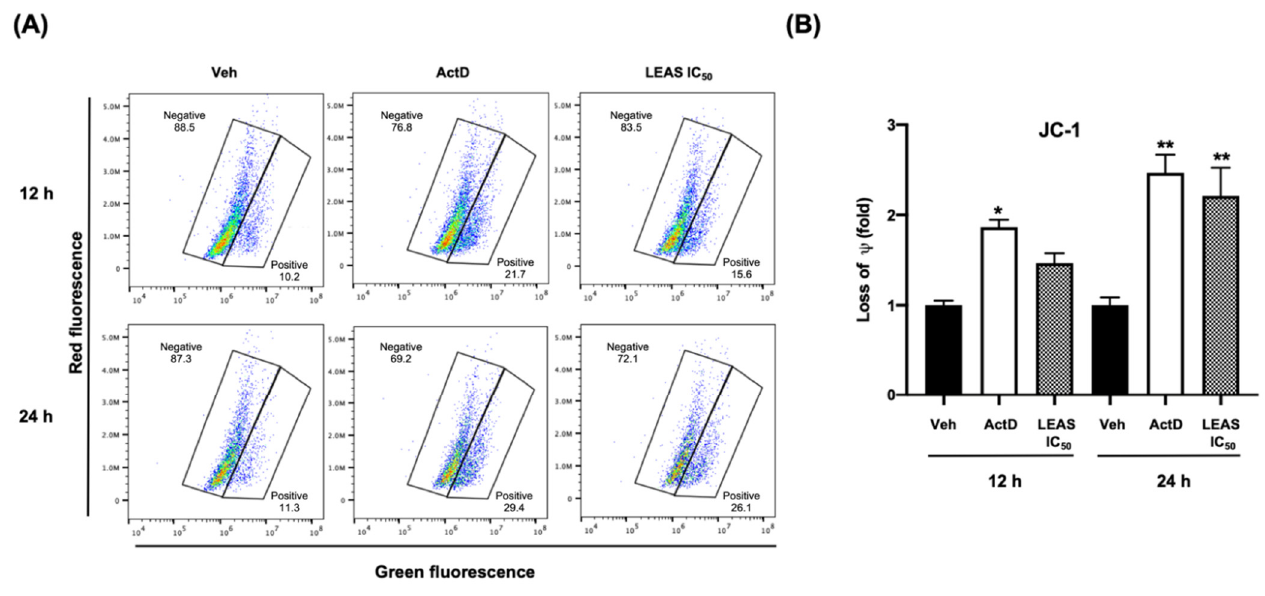
Figure 5 . LEAS generates the loss of mitochondrial membrane potential ( ΔΨ m) in D-17 cells. ( A ) The mitochondrial membrane potential was evaluated by flow cytometry using the JC-1 dye. Cells were treated for 12 h and 24 h with LEAS IC 50 (15.5 µg/mL), vehicle, or Act D. Representative plots are shown. ( B ) The graphic shows fold-change values for each time of treatment. Each bar shows the mean of triplicates ± SE of two independent experiments. “*” and “**” Indicates statistically significant differences with relation to the vehicle at the time evaluated ( p < 0.05). ActD = Actinomycin D (80 µg/mL). Veh = vehicle (DMSO 0.1%).